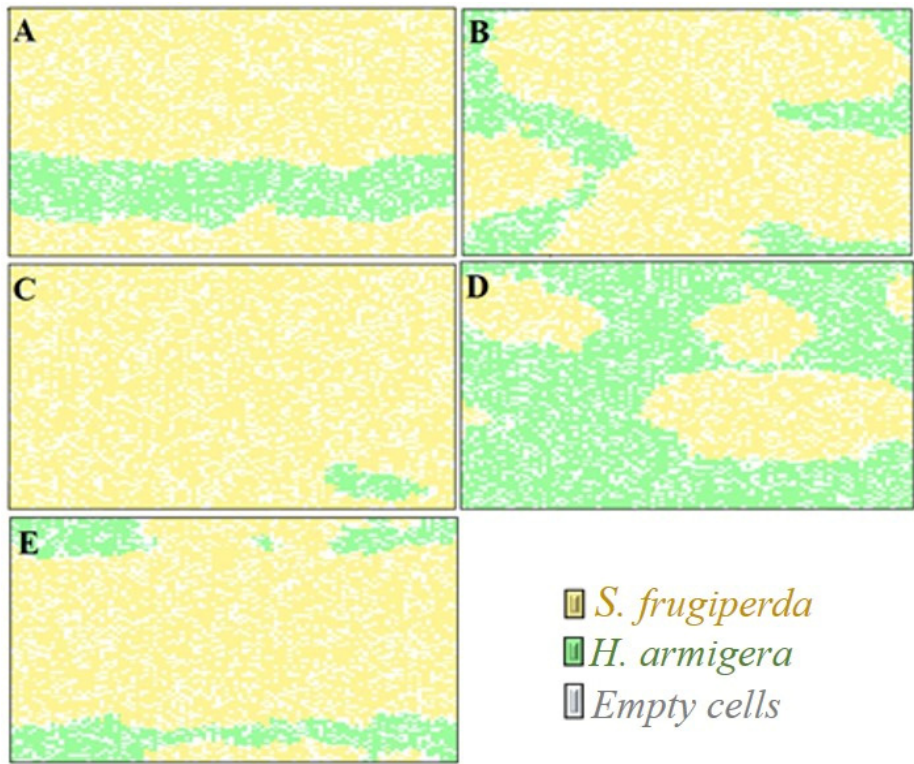
Figure 3. Visual representation of the occupation of patches by S. frugiperda and H. armigera after 80 time steps in the following conditions: ( A ): absence of insecticide control. ( B ): insecticide control and absence of cases of insecticide resistance. ( C ): insecticide control and resistance of S. frugiperda to the insecticide. ( D ): insecticide control and resistance of H. armigera to the insecticide. ( E ): insecticide control and resistance of S. frugiperda and H. armigera to the insecticide. (For a color version of this figure, the reader is referred to the web version of this article.)